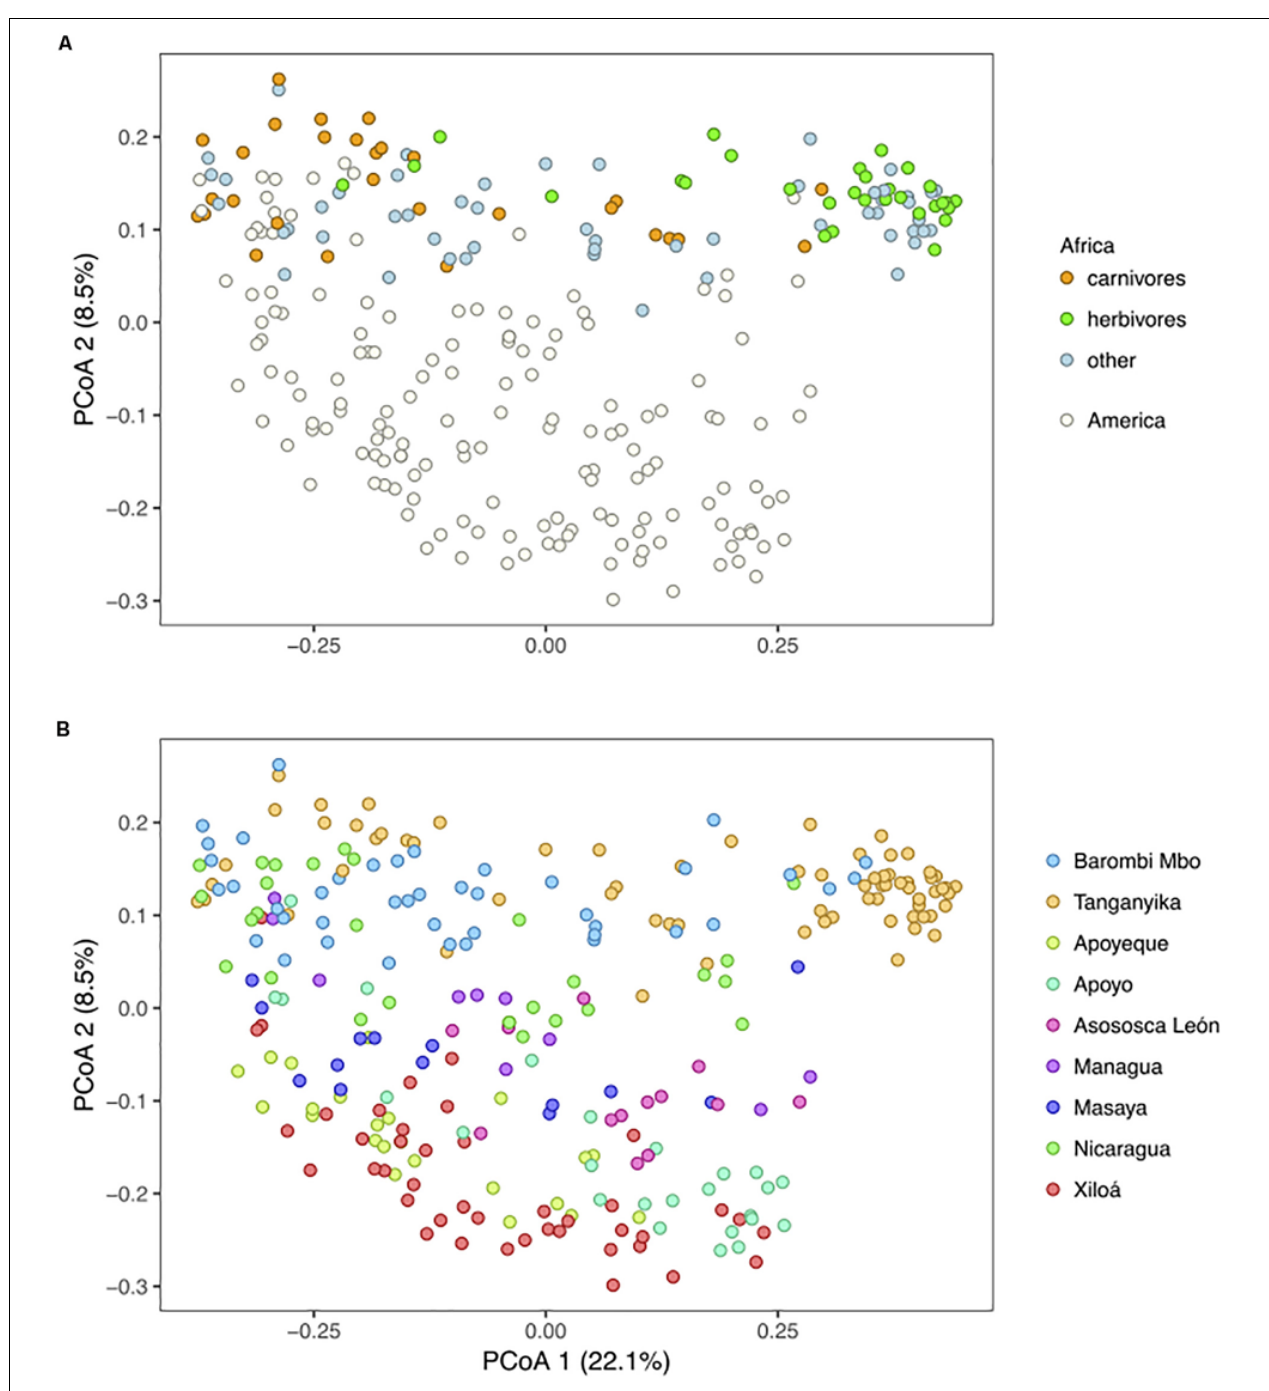
FIGURE 6 | Principal Coordinates Analysis based on Unweighted Unifrac distances depicting clustering by continent and diet (A) and by lake (B) . (A) For the American dataset, major specimen dietary classification is given according to Baldo et al. (2017). PC2 captures the geographic separation between continents and partially among lakes, while PC1 substantially explains variation within lakes, driven by species and/or ecology. Circles represent specimens. The analyses are based on the rarefied dataset